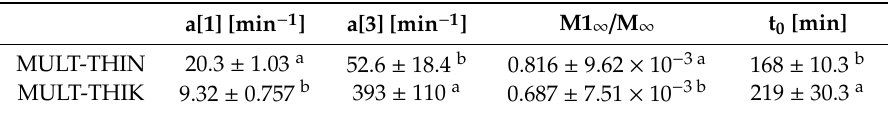
Table 1. Fitting parameters of multilayer